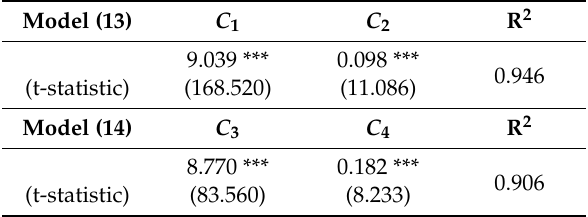
Table 5. Regression results of models (13) and (14) in W